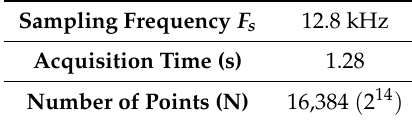
Figure 7. Sensors installed in the axle box cover and measurement directions. Table 5. Parameters of signals measured for each